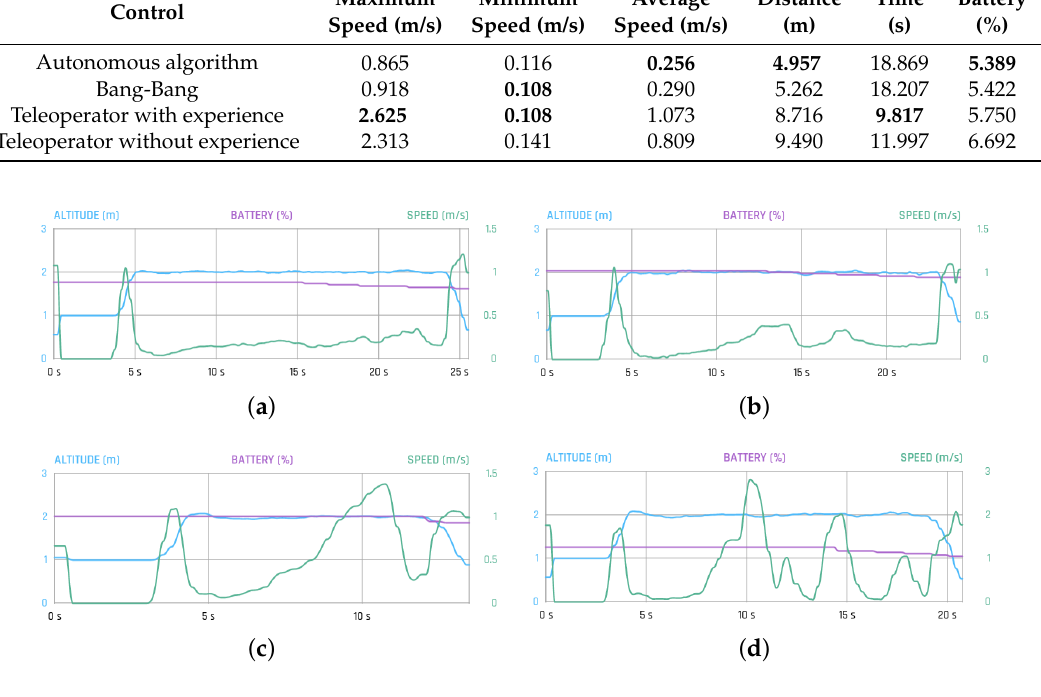
Figure 22. Results of one fixed obstacle for four different controllers. ( a ) Autonomous control; ( b ) bang-bang control ( c ) teleoperator with experience; ( d ) teleoperator without